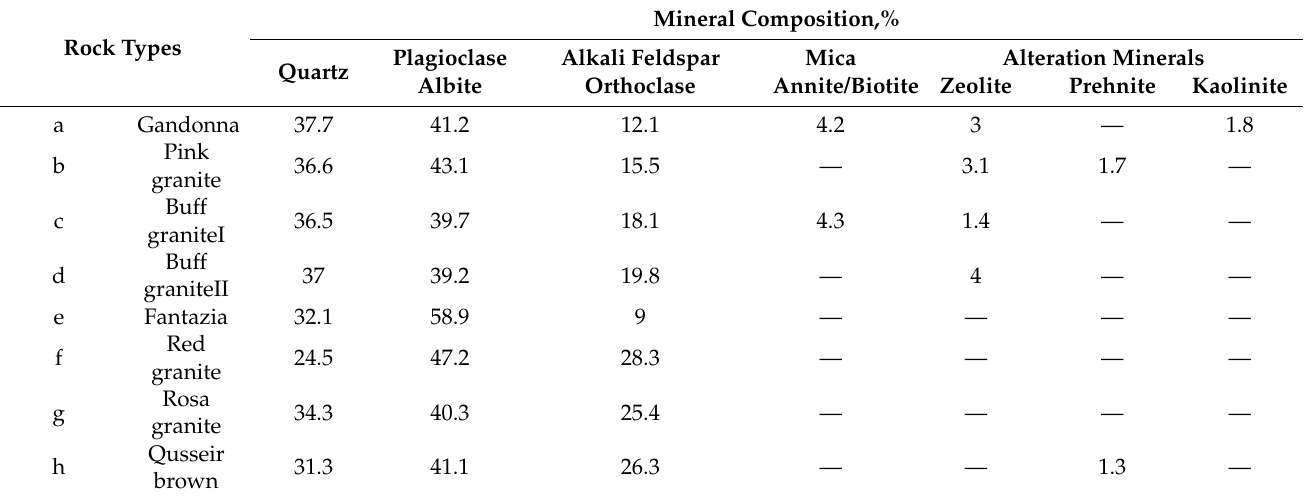
Table 3. Quantitative mineral composition of granitic rock types using Rietveld refinement